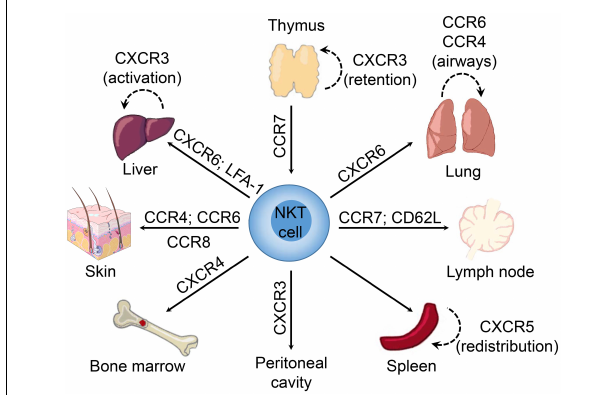
FIGURE 1 | Chemokine receptors involved in tissue-dependent NKT cell homing . Following their development in the thymus, NKT cells emigrate to peripheral tissues (including liver, spleen, lung, bone marrow, lymph nodes, skin, and the peritoneum) where their accumulation and/or retention is regulated by adhesion molecules and chemokine–chemokine receptor interactions. Chemokine receptors and adhesion molecules associated with NKT cell redistribution within these tissues are